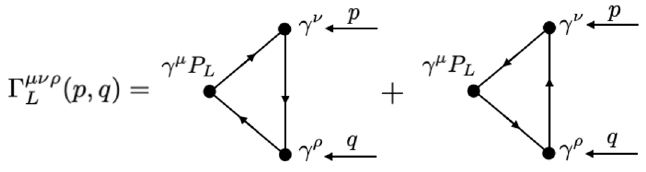
Figure 1 . Triangle diagrams leading to anomalies in the unbroken phase. Solid lines are fermion propagators and we indicate which combination of Dirac matrices enters each